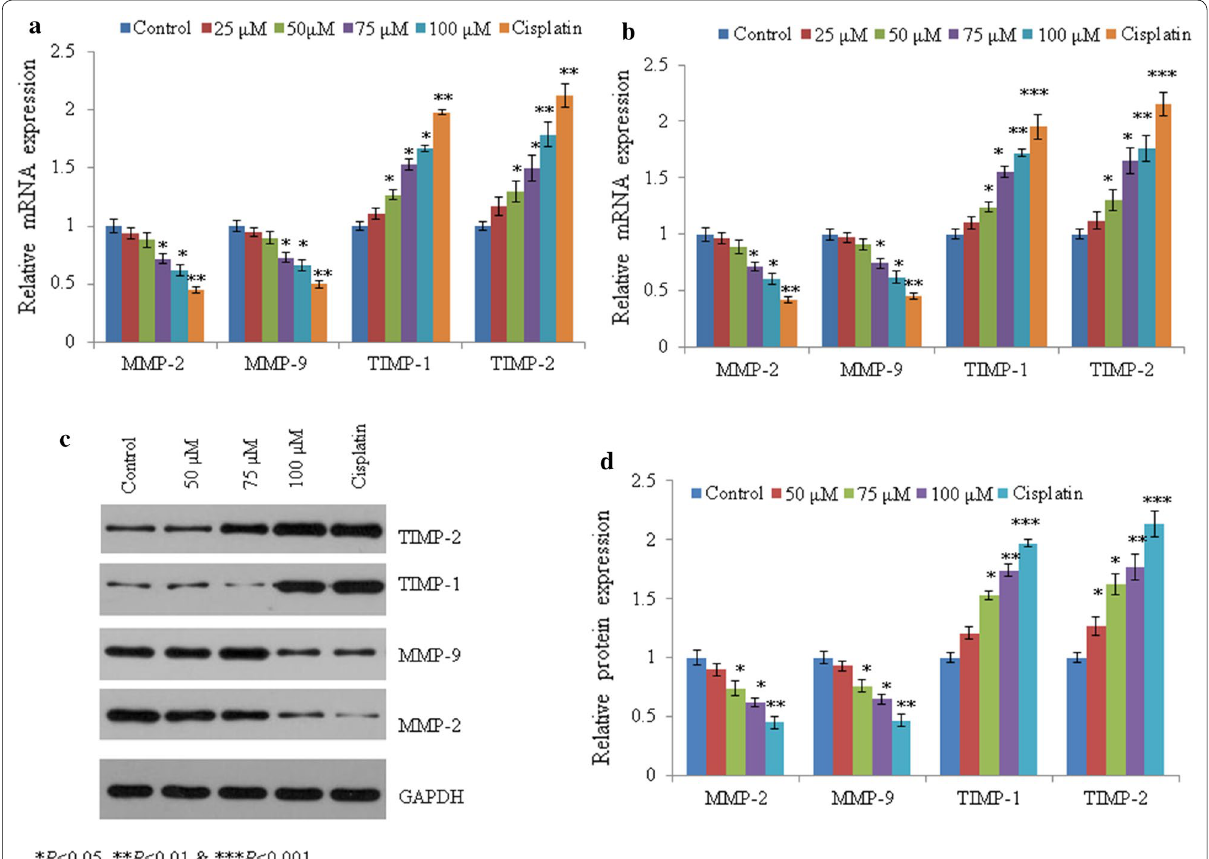
Fig. 6 Effect of mangiferin on the mRNA and protein expression of TIMP-1/2 and MMP-2/9 in osteosarcoma cells. Cells were incubated with mangiferin (25–100 µM) for 72 h. a Represents the mRNA expression in Saos-2 cells and b mRNA expression in U2OS cells. c Western blot bands in Saos-2 cells and d densitometry analysis of C. N 6. Control vs. * P < =